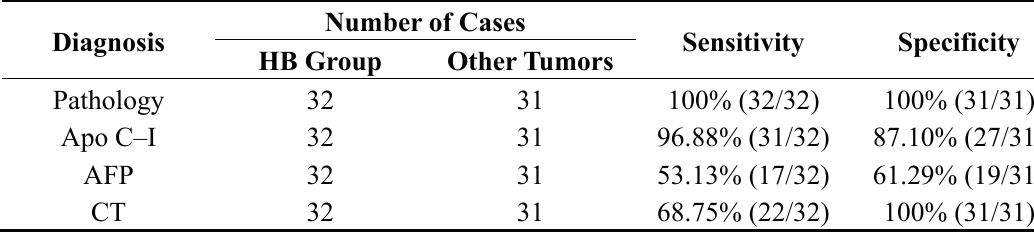
Table 6. Sensitivity and specificity of various diagnosis methods between HB and other pediatric abdominal solid